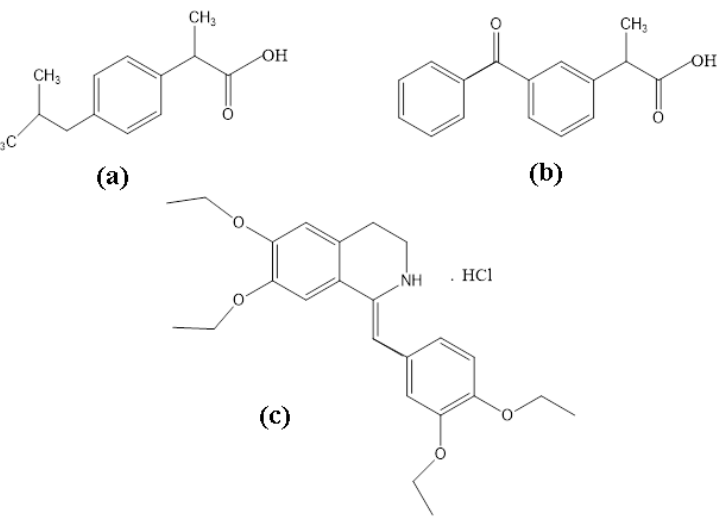
Figure 1. Structural formula for: ( a ) Ibuprofen (Ibu), ( b ) Ketoprofen (Ket) and ( c ) Drotaverine Hydrochloride (D-HCl).